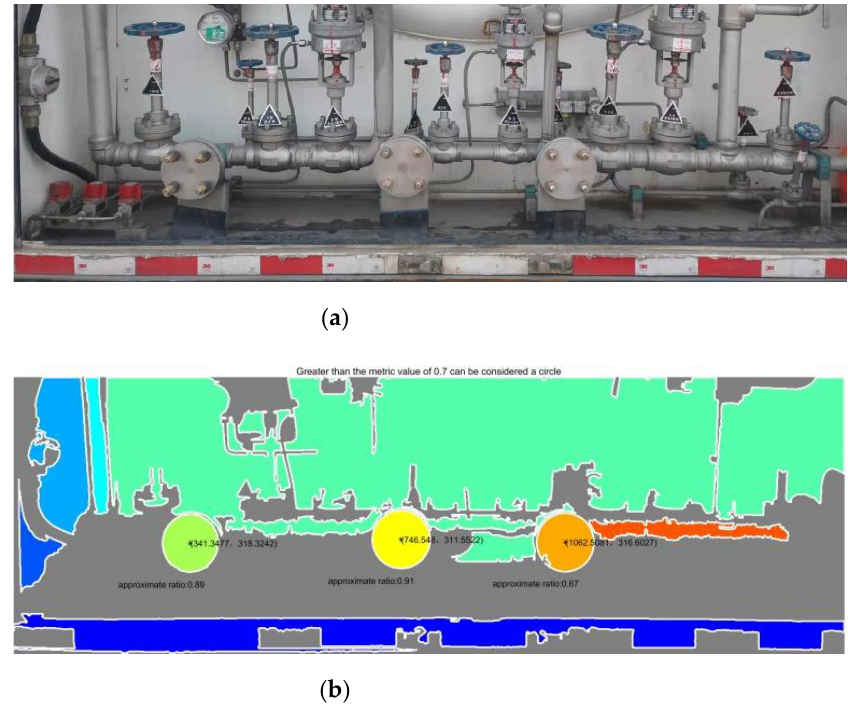
Figure 14. On-site tank car B. ( a ) Flange practicality picture. ( b ) Detection results of ( a ).